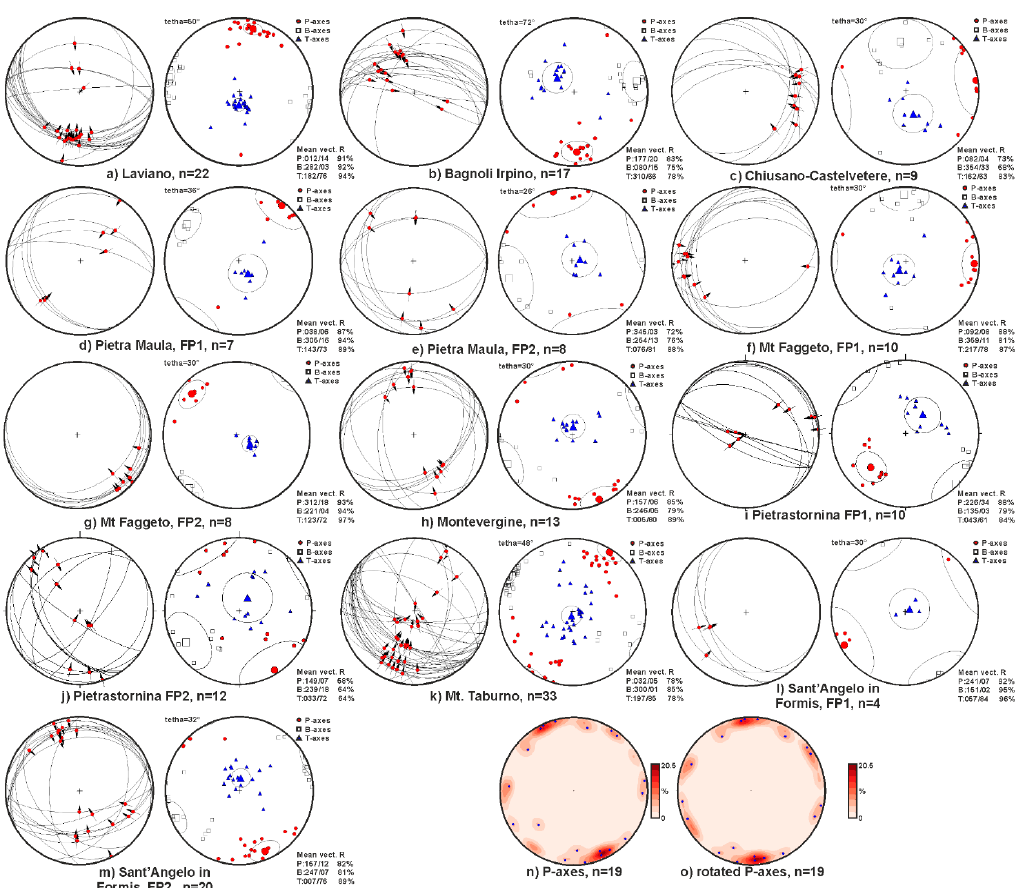
Figure 5. Stereographic projections of ( a – m ) faults and corresponding PBT plots; ( n ) T-axes; ( o ) T-axes rotated 20° counterclockwise.